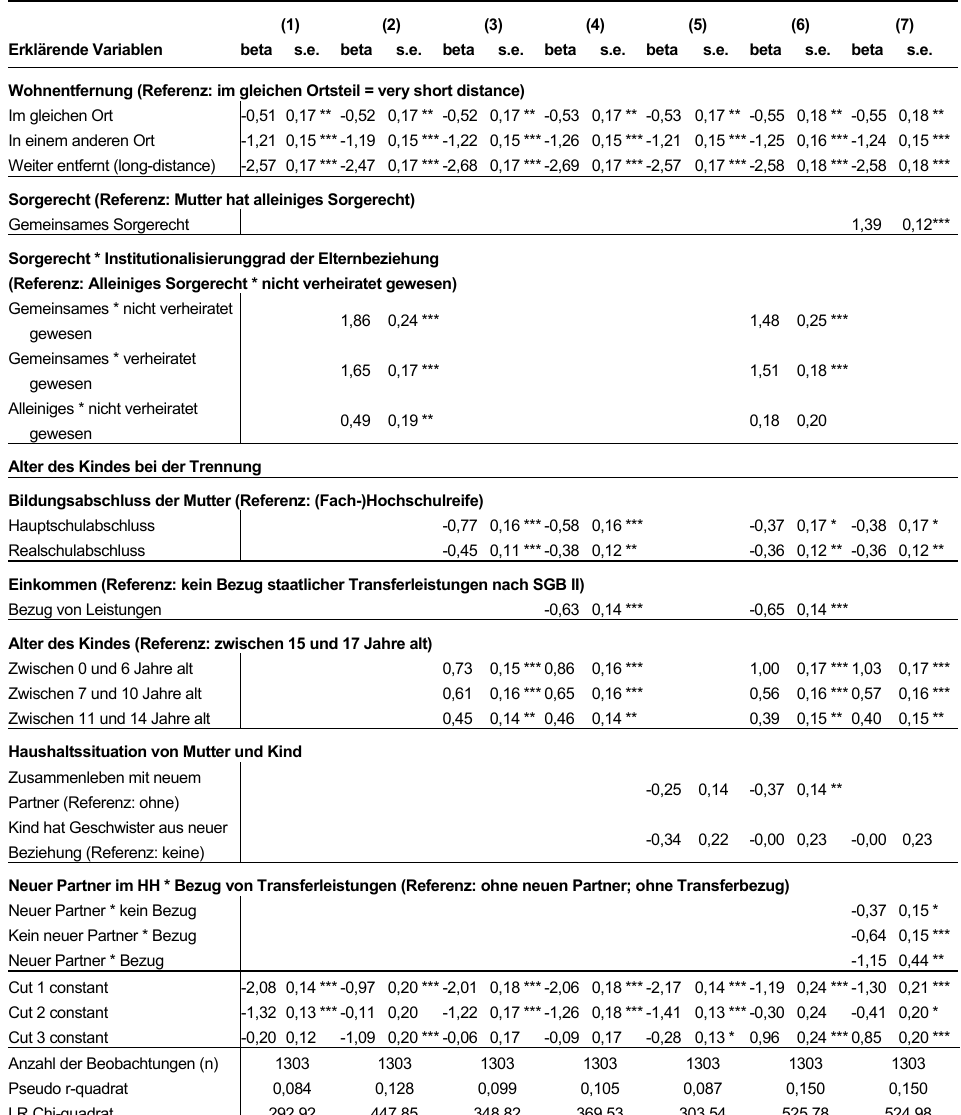
Tabelle 3 : Determinanten der Kontakthäufigkeit für